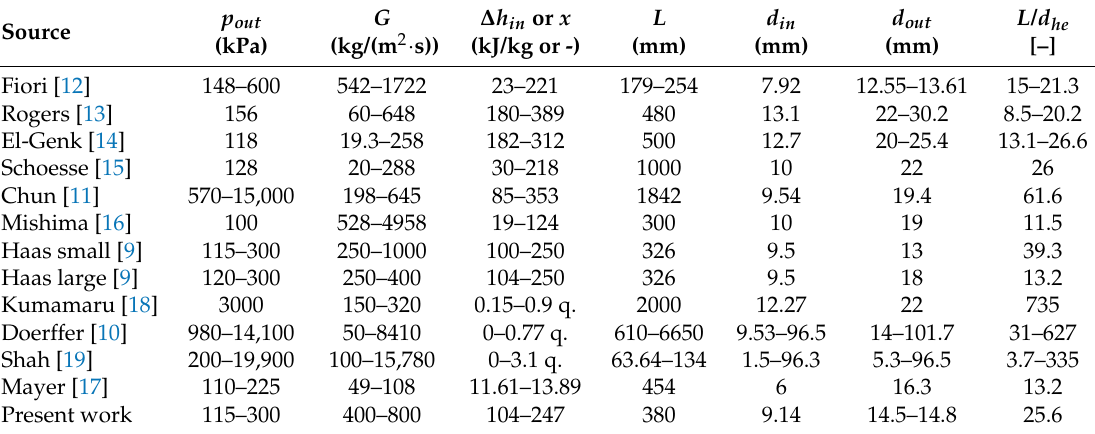
Table 1. Experimental parameters of literature data of critical heat flux (CHF) experiments in annular